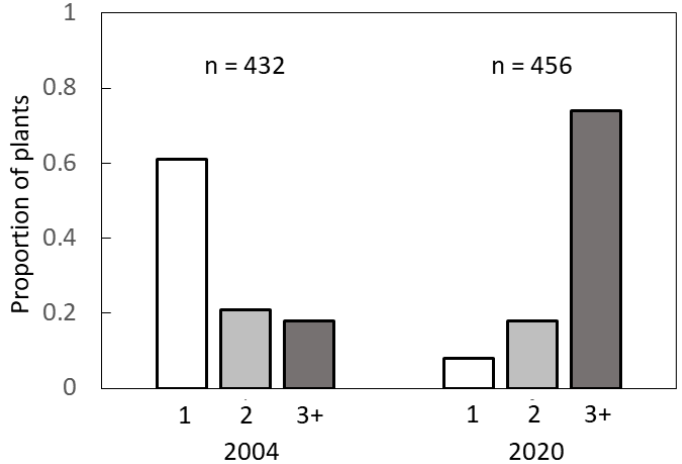
Figure 3. The influence of year on the proportion of Cycas micronesica plants with 1, 2 or 3 + branches. n represents the total number of trees in each census.